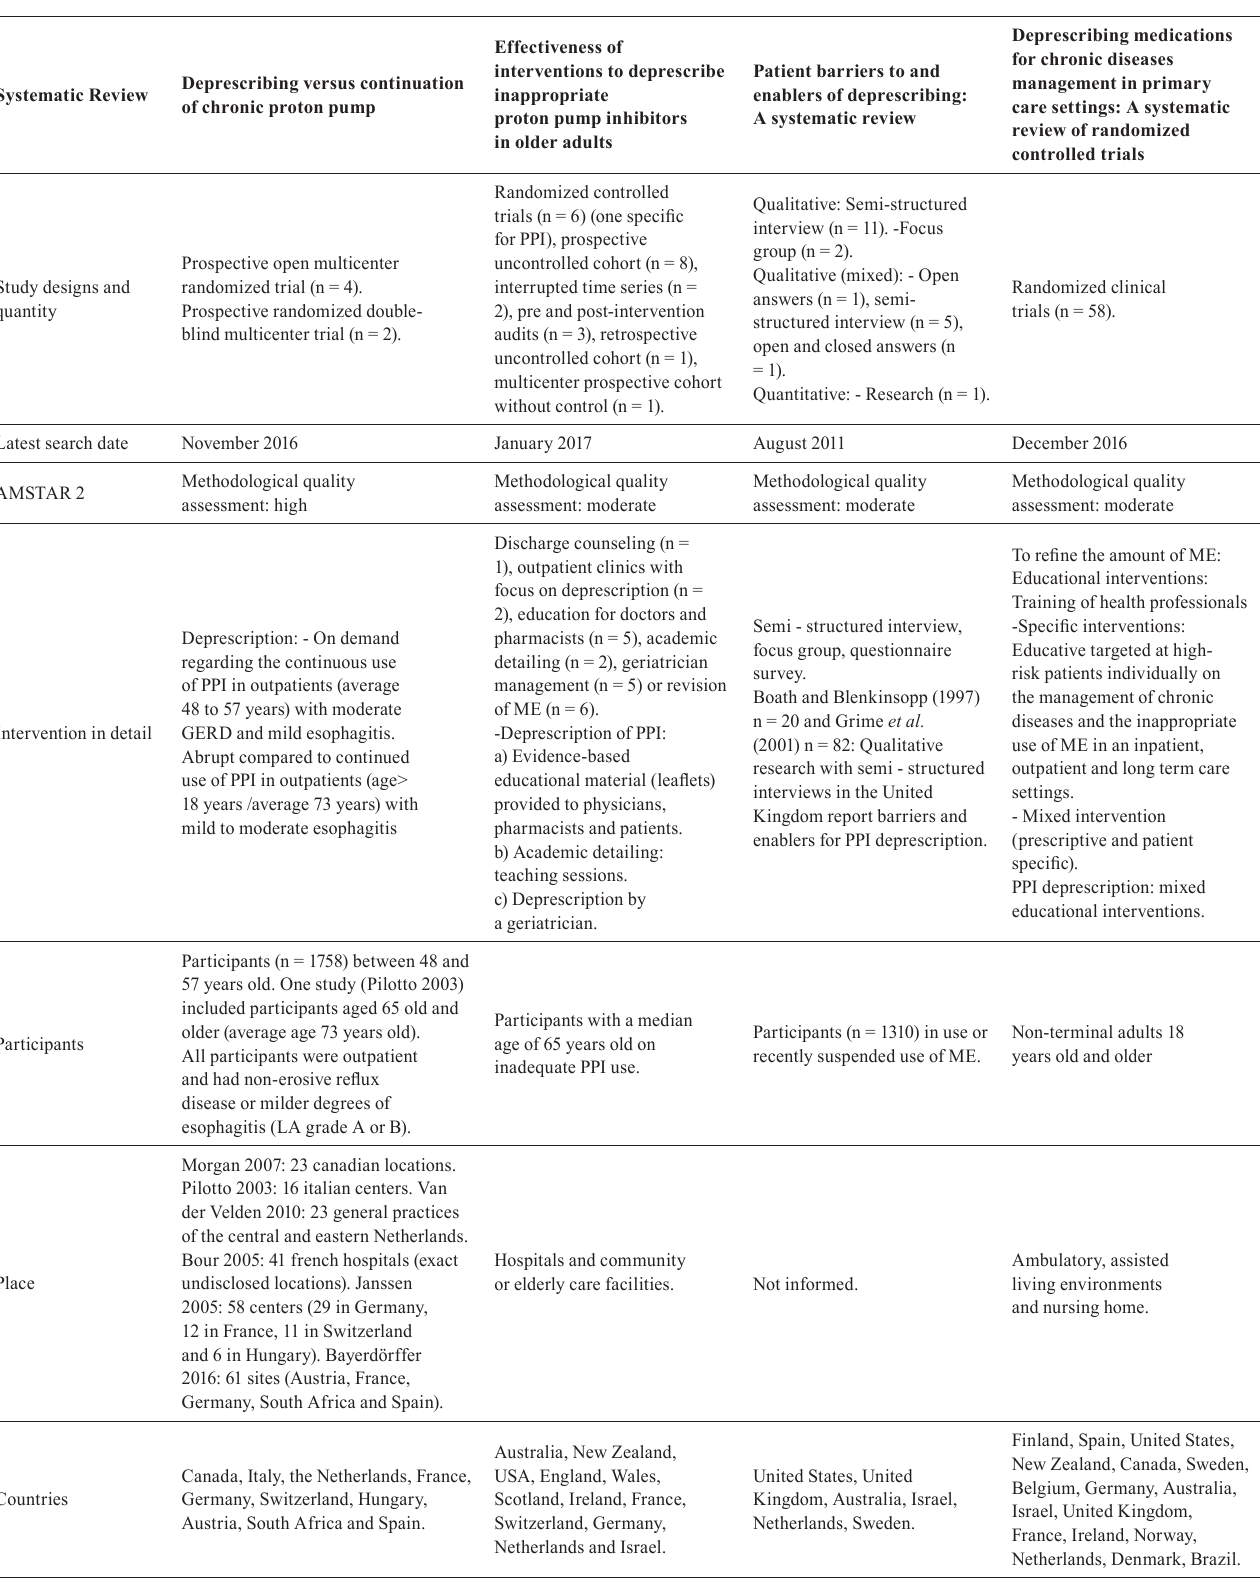
TABLE II - Characteristics of the included studies